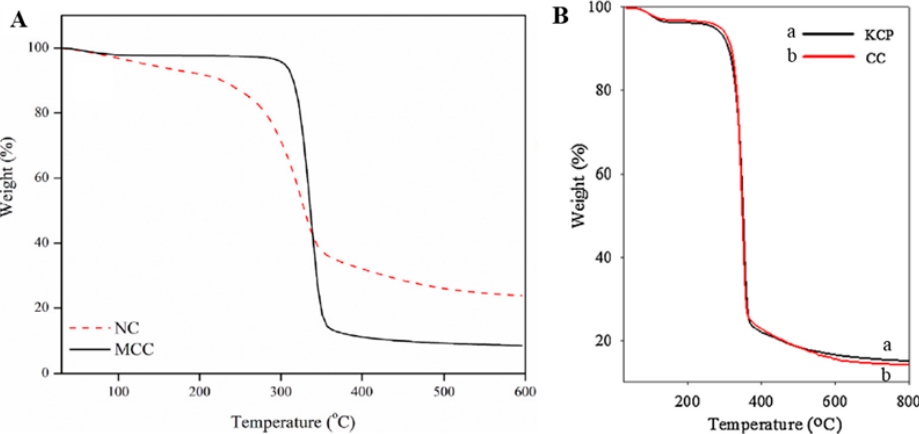
Figure 4. ( A ) TGA curves of MCC and nanocellulose (NC) (reproduced from [45]); and ( B ) TGA curves of kenaf core pulp and cellulose carbamate (reproduced from [46]).